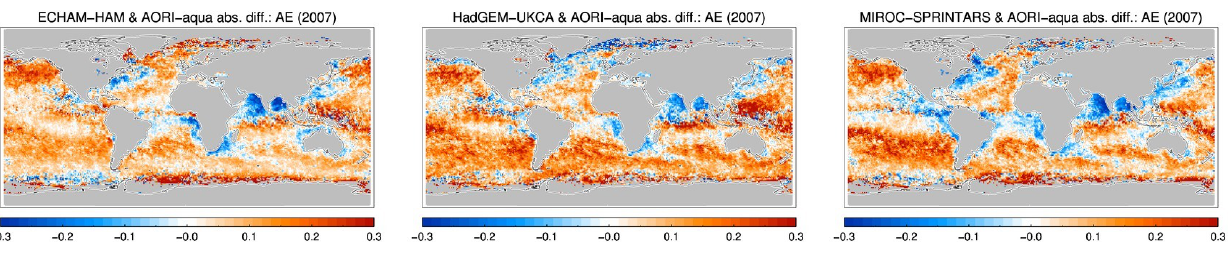
Figure 9. Global map of absolute temporal sampling error using MODIS-AORI Aqua AE sampling. Grey colors indicate no observations